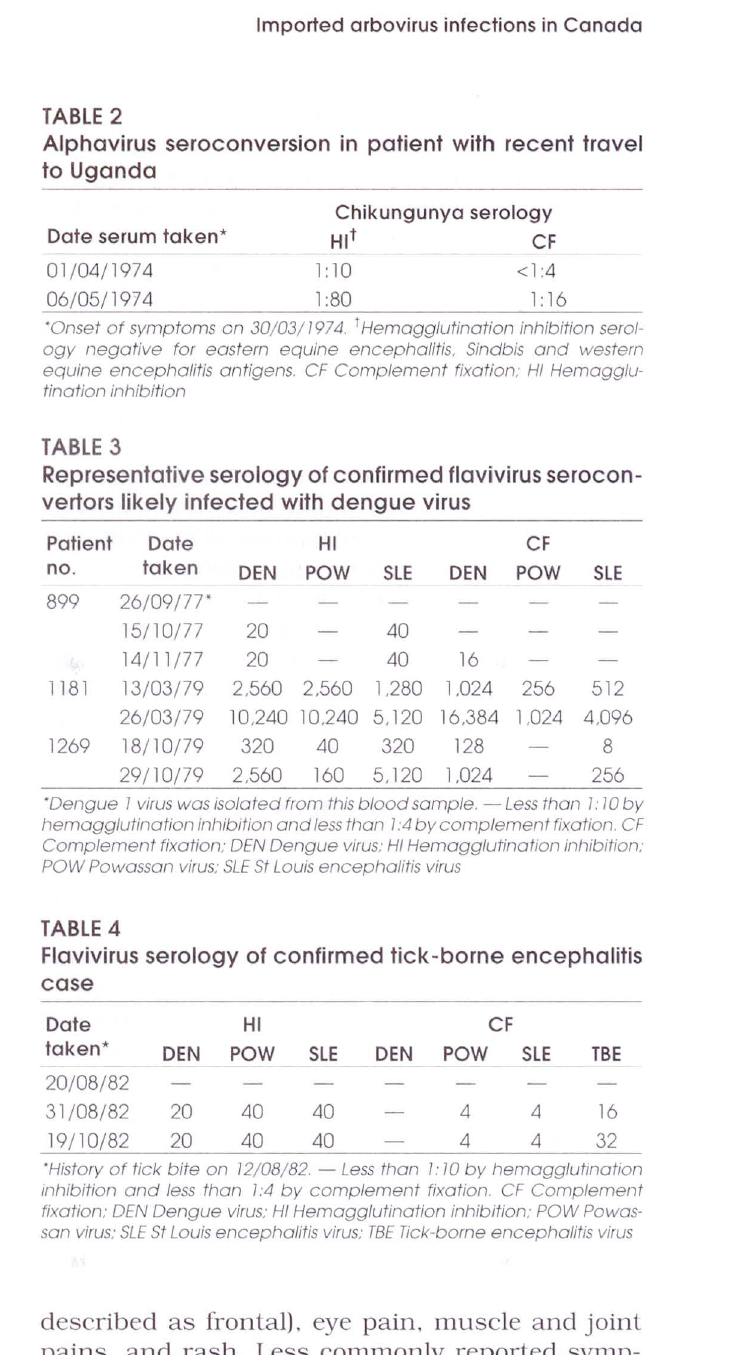
Flavivirus serology of confirmed tick-borne